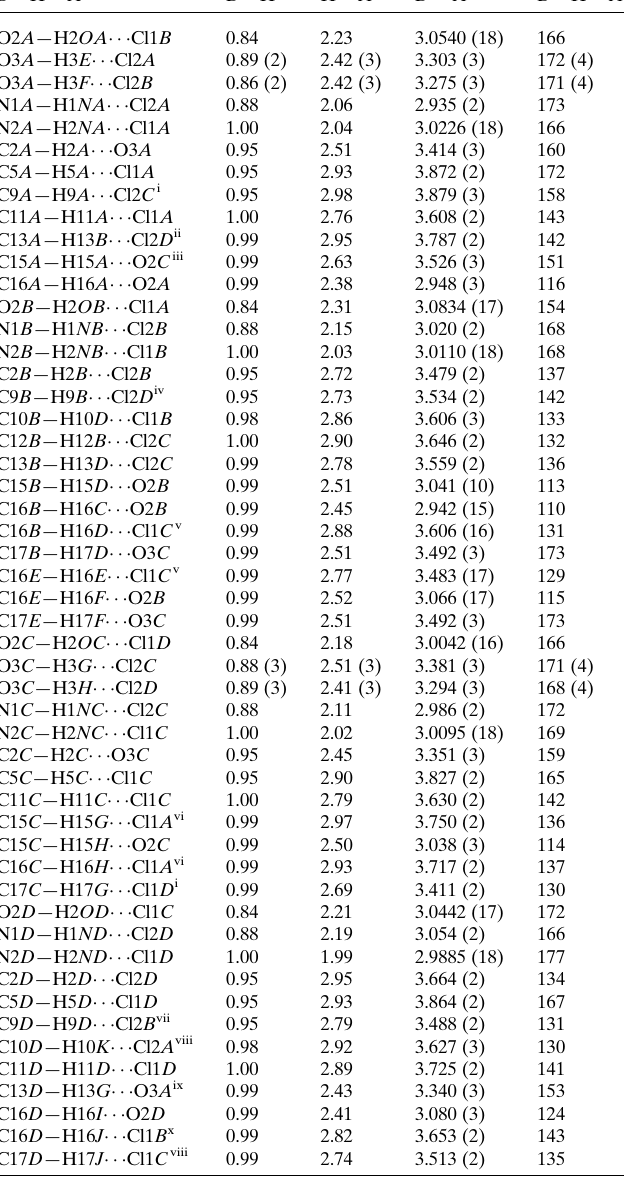
Table 2 Experimental details. Crystal data Chemical